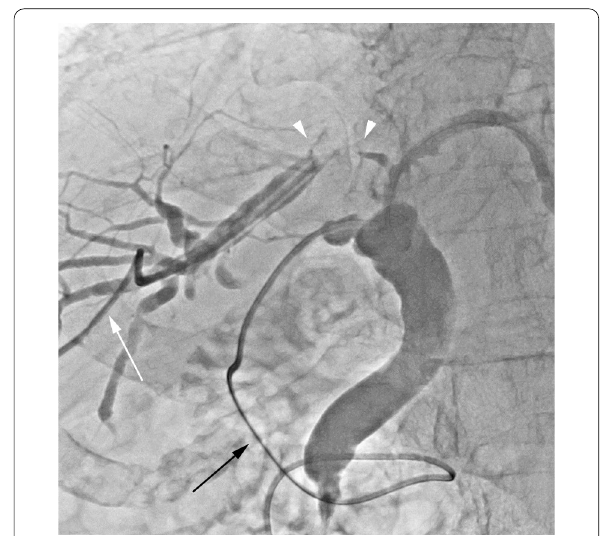
Fig. 2 The cholangiogram via the PTBD catheter (white arrow) in the posterior segmental duct and the C-tube (black arrow) inside common bile duct demonstrates complete obstruction 15 mm in length in the right hepatic duct (white